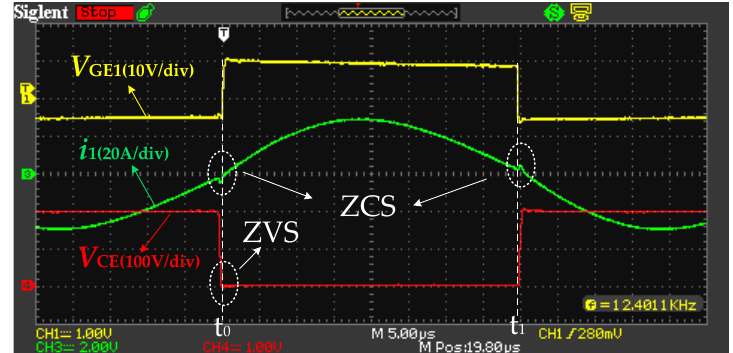
Figure 12. Soft-switching